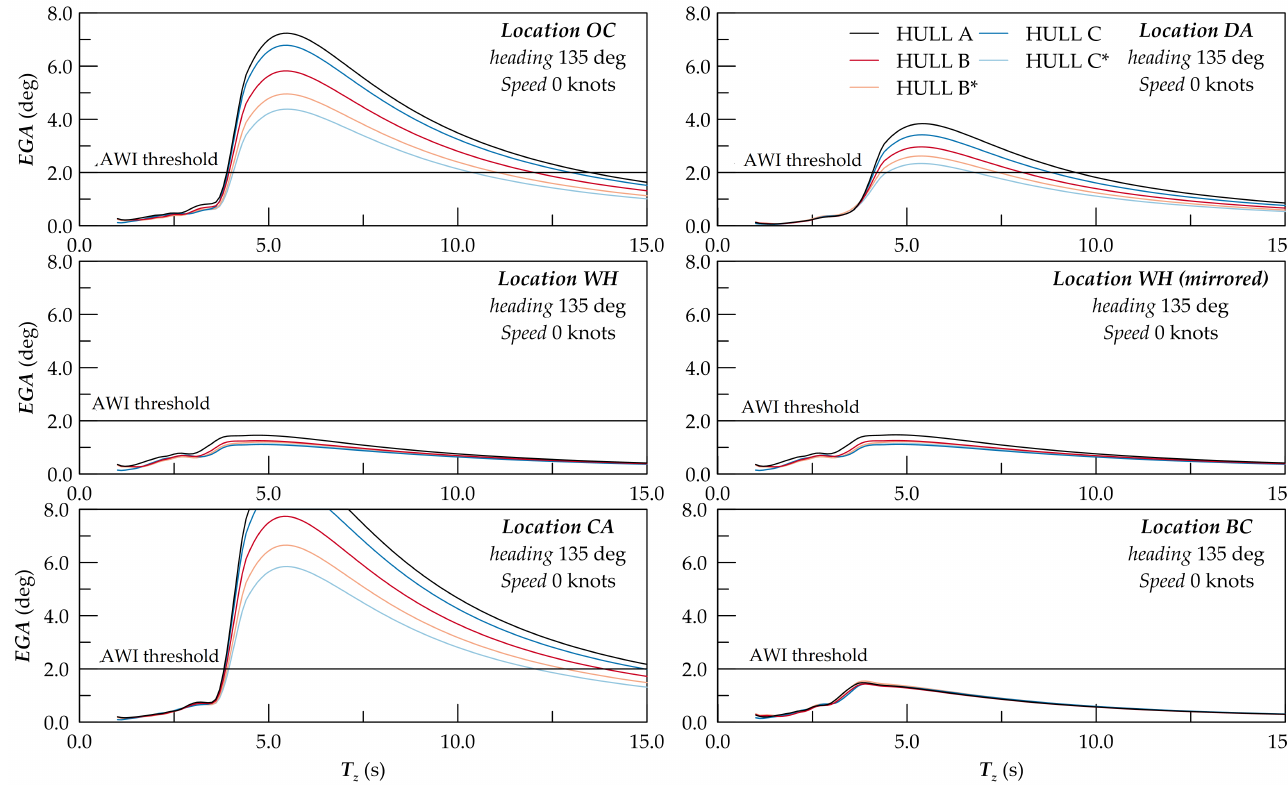
Figure 18. EGA values for H s = 1.5 metres at different T z for the AWI 22834 locations at 0 knots.